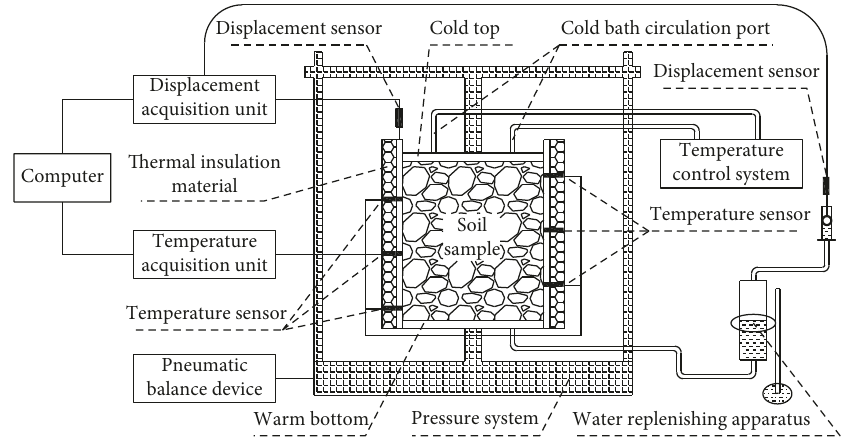
Figure 4: Schematic diagram of the improved frost heave experiment apparatus.